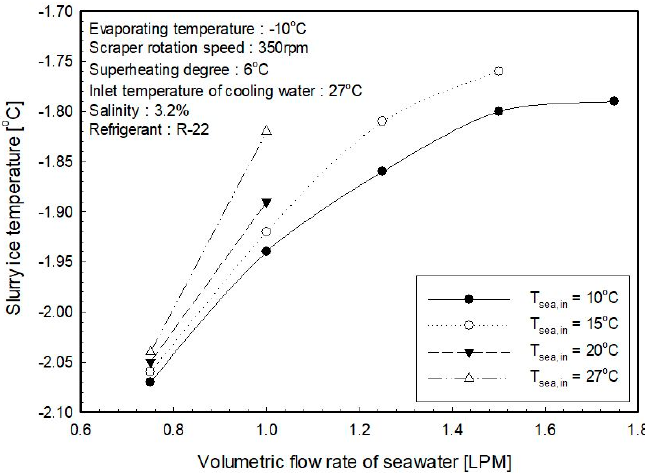
Figure 5. Influence of seawater flow rate on temperature of ice slurry for inlet temperature of seawater.